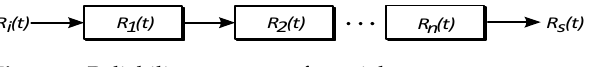
Figure 1. Reliability structure of a serial system.